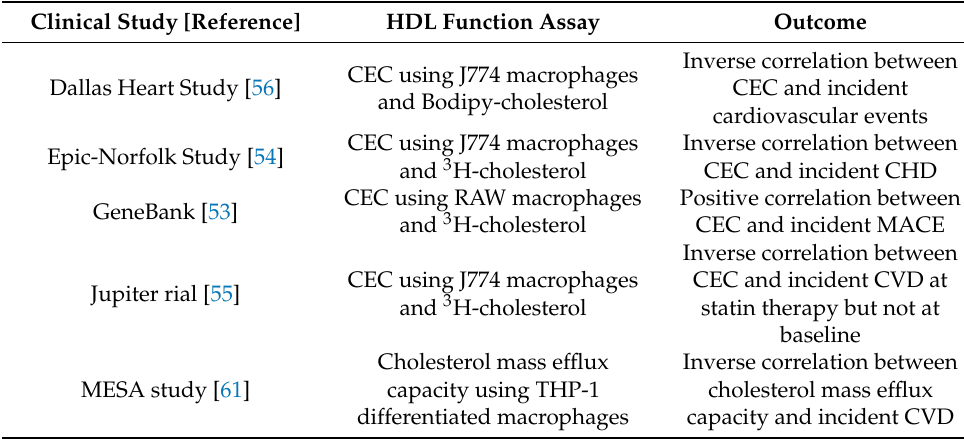
Table 1. Prospective clinical studies of HDL function assays.